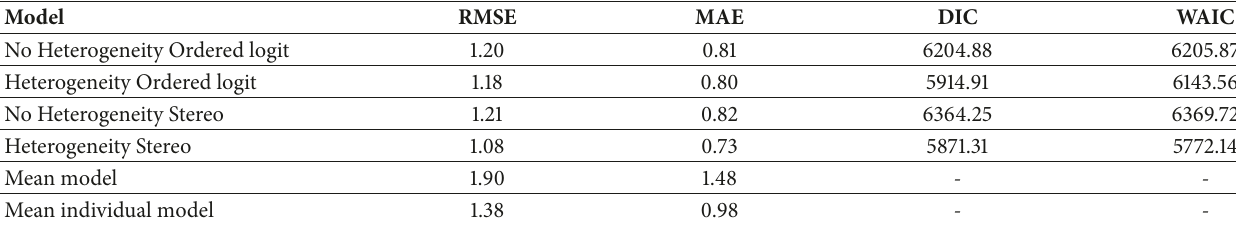
Table 1: Results: performance for each model based on performance